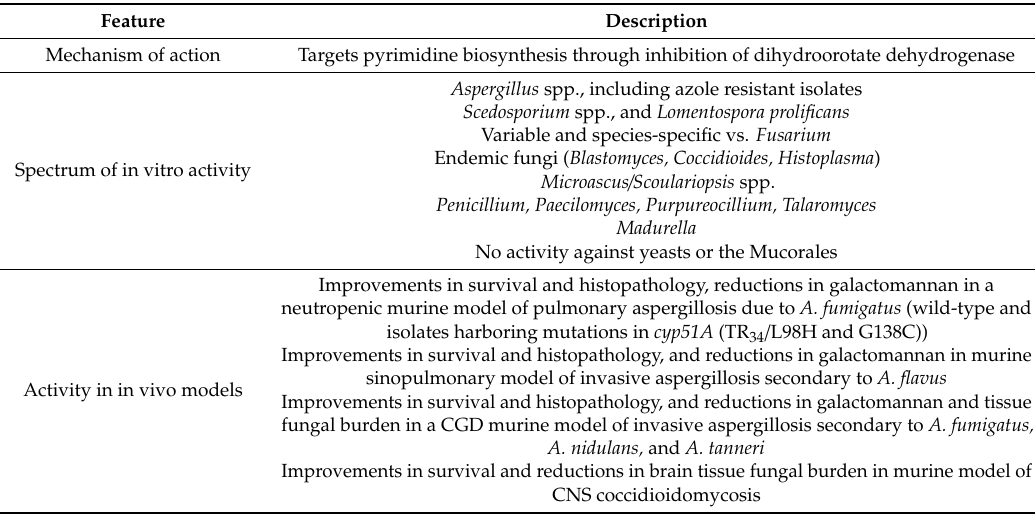
Figure 1. Structure of olorofim (F901318). Table 1. Key in vitro and in vivo features of olorofim